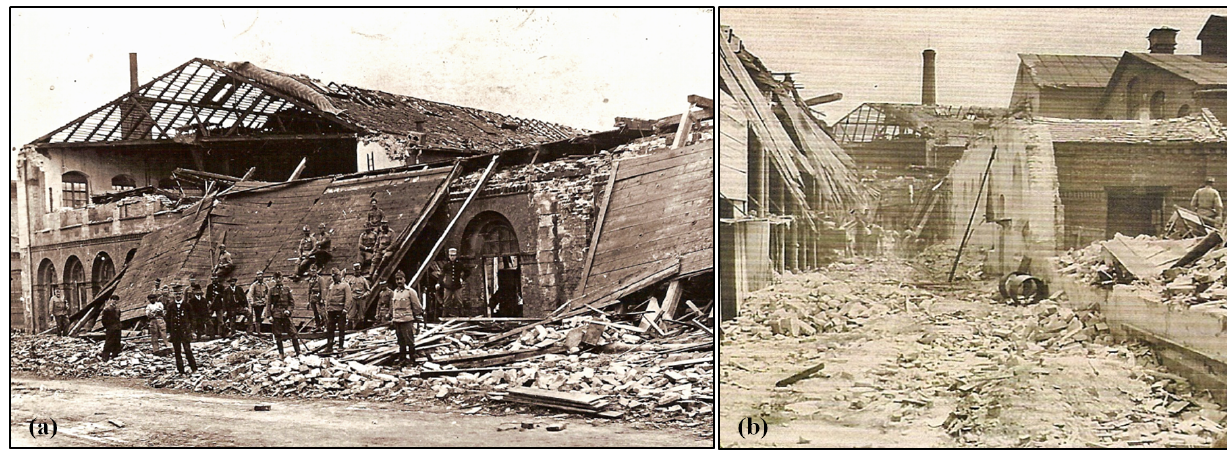
Figure 3. Details of the old locomotive factory. (a) Inner ceiling flipped outside, in the foreground the whole upper floor with massive brick walls has collapsed (similar as the building parts that are still visible in the background). (b) Former indoor part of the same building with